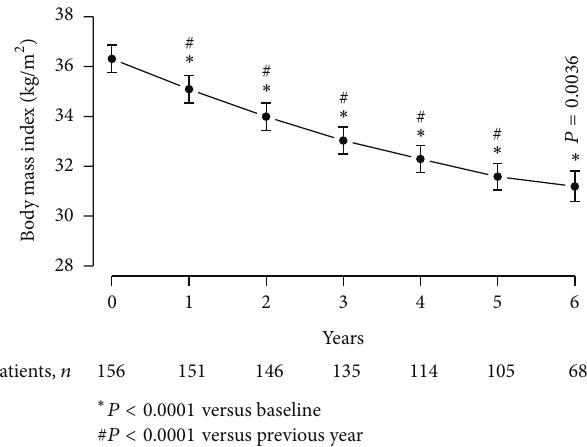
Figure 3: Weight change from baseline (%) in 156 obese hypogo- nadal men with type 2 diabetes mellitus treated with testosterone undecanoate injections for up to 6 years.